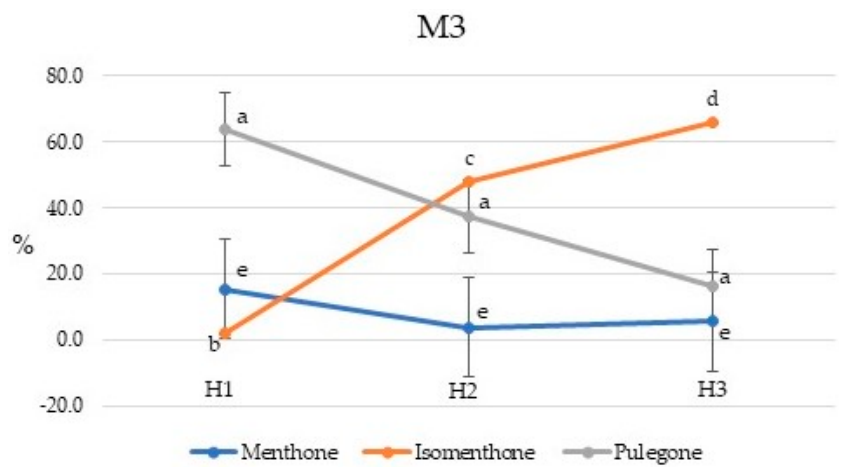
Figure 6. Seasonal variation in the menthone, isomenthone, and pulegone percent concentrations for Pycnanthemum virginianum variety M3. Percent concentrations with same letter are not significantly different at p ≤ 0.05. H1, H2, and H3 are harvest times, 135, 155, and 170 days after planting, respectively.